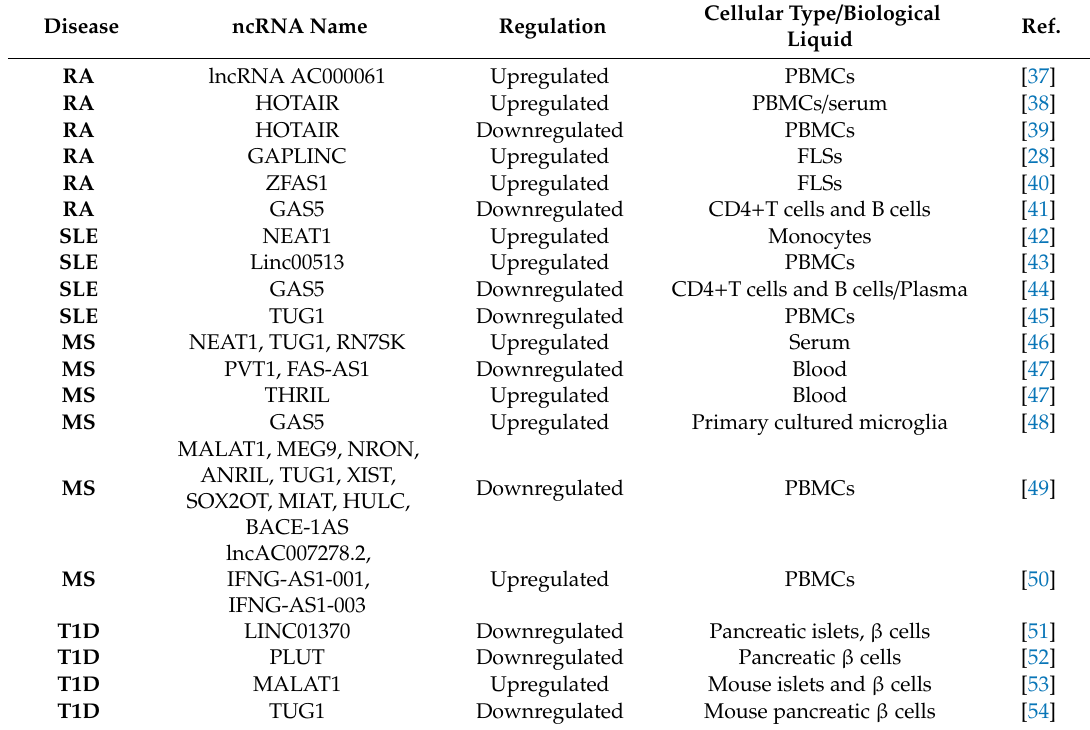
Table 1. lncRNA in autoimmune diseases (ADs).